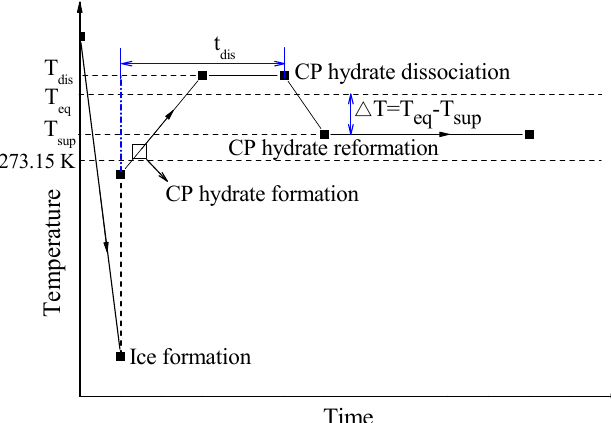
Figure 2. The temperature profile of cyclopentane (CP) hydrate formation and dissociation in a capillary.